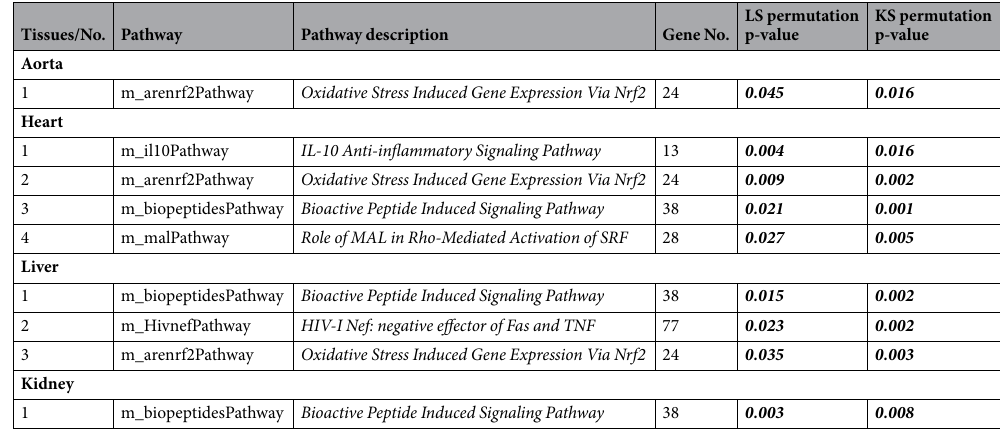
Table 6. Validation results of pathway analysis based on mouse data. LS permutation: Least square permutation; KS permutation: Kolmogorov–Smirnov permutation. The LS/KS permutation tests, which find gene sets that have more differentially expressed genes among the classes than expected by